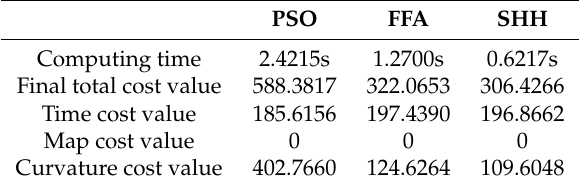
Table 3. Results comparison using PSO, FFA and SHH algorithms in scenario 2.